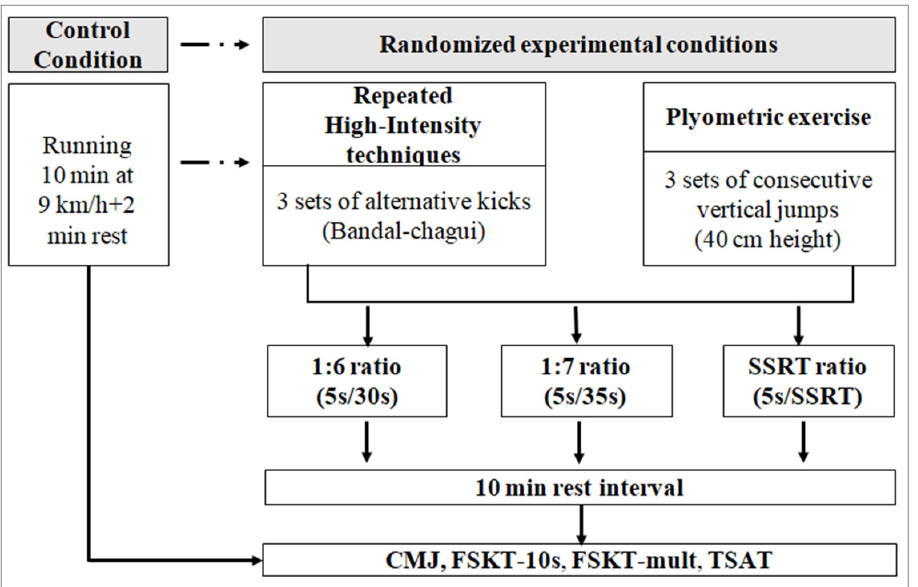
Figure 1. Schematic representation of the study design. SSRT: self-selected rest time, CMJ: counter- movement jump test, CA: conditioning activity, TSAT: taekwondo-specific agility test, FSKT-10s: 10 s frequency speed of kick test, FSKT-mult: multiple frequency speed of kick test.